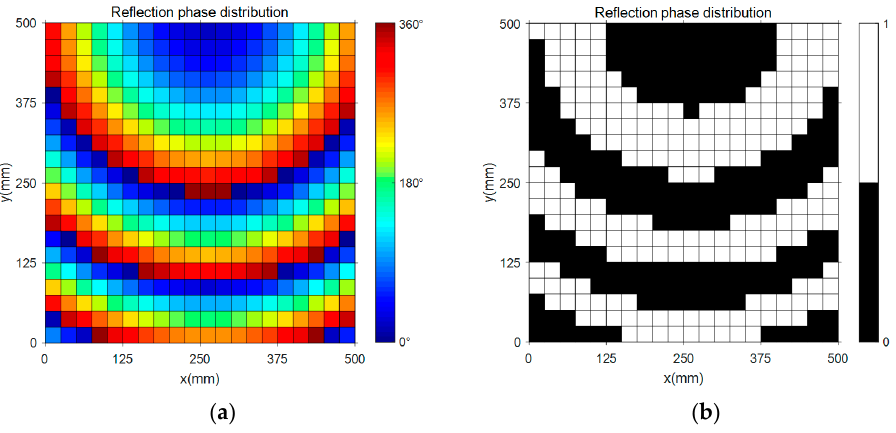
θ = ° ( a ) Accurate phase distribution; ( b ) r